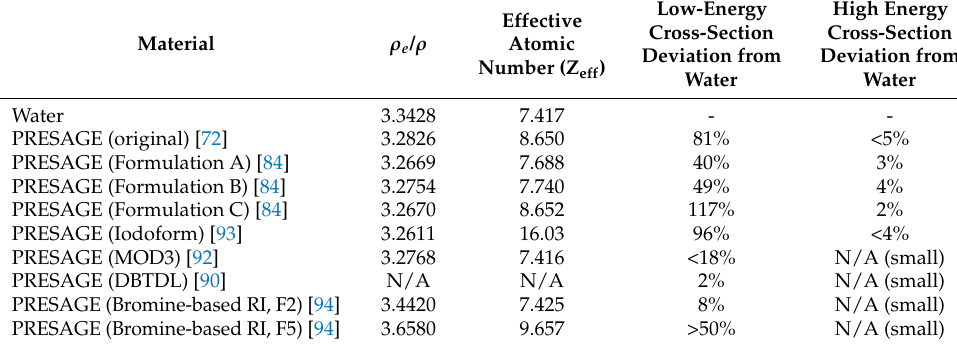
Table 1. The low-energy and high-energy cross-section of